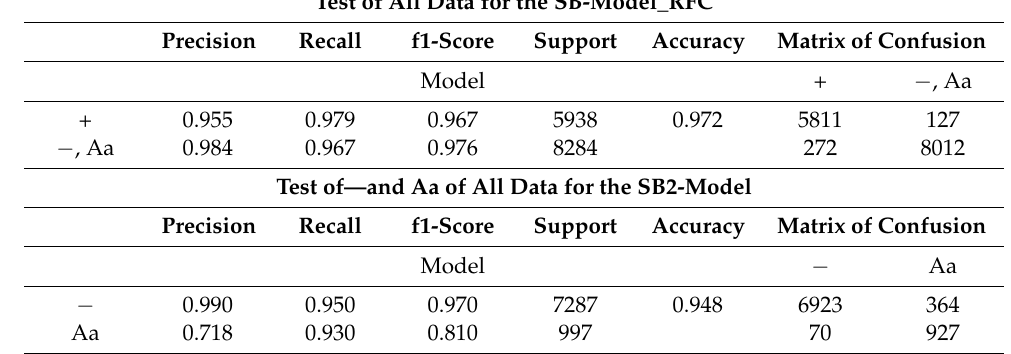
Table 4. Confusion matrix and evaluation criteria for the test using all data for SB-model_RFC and SB2-model.